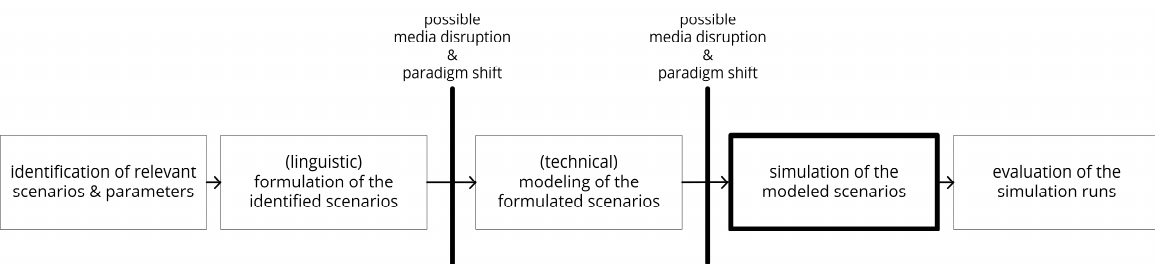
Figure 9. Potential media disruptions and paradigm shifts within the simulation and scenario-based testing